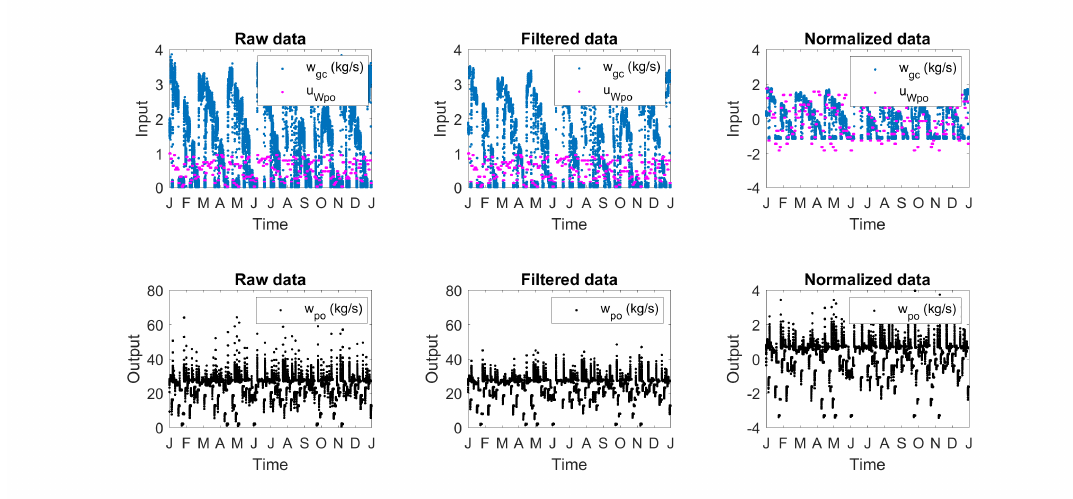
Figure 8. One year of the gas lift well operation.